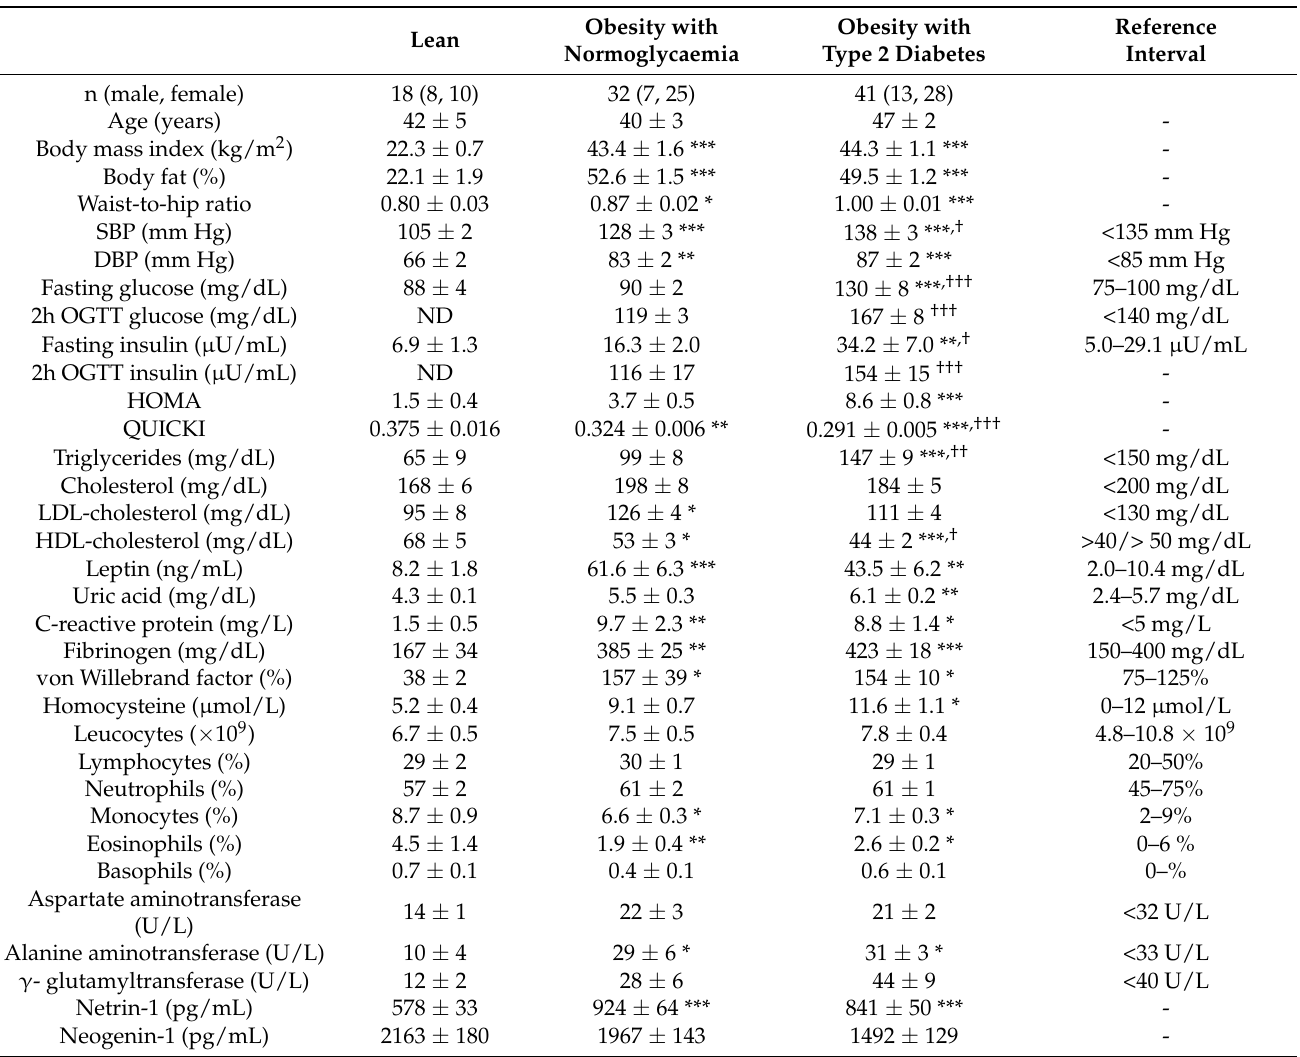
Table 1. Clinical and biochemical characteristics of the subjects included in the study. Obesity with Obesity with Lean Normoglycaemia Type 2